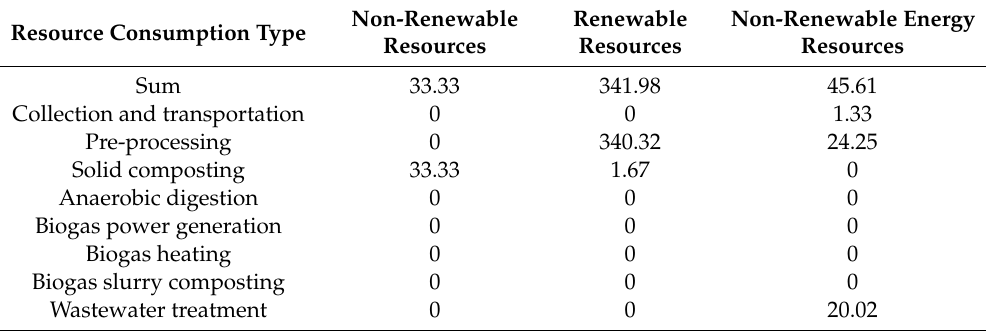
Table 3. Resource consumption of the life cycle of restaurant food waste (unit: